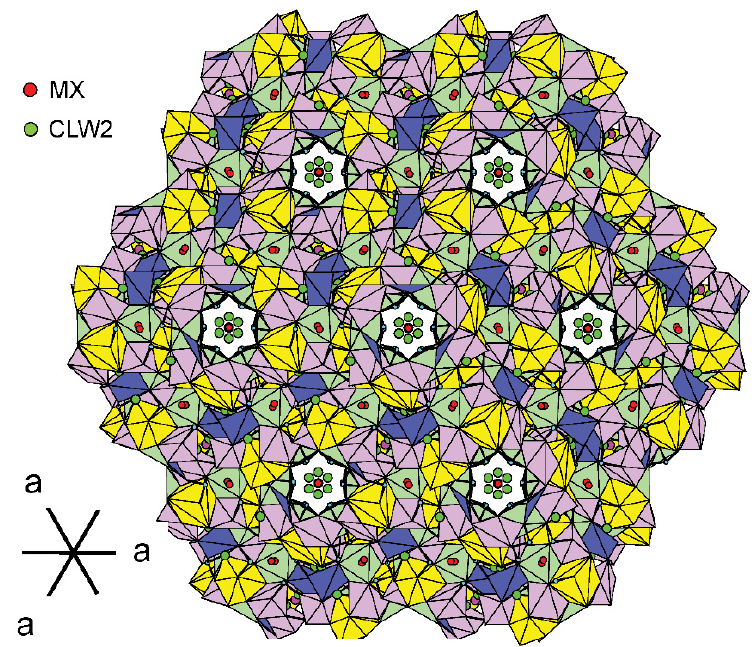
Figure 6. View of magnussonite atomic arrangement down [111], illustrating the channels in structure. The [Mn + (As 3+ O 3 ) 6 ]